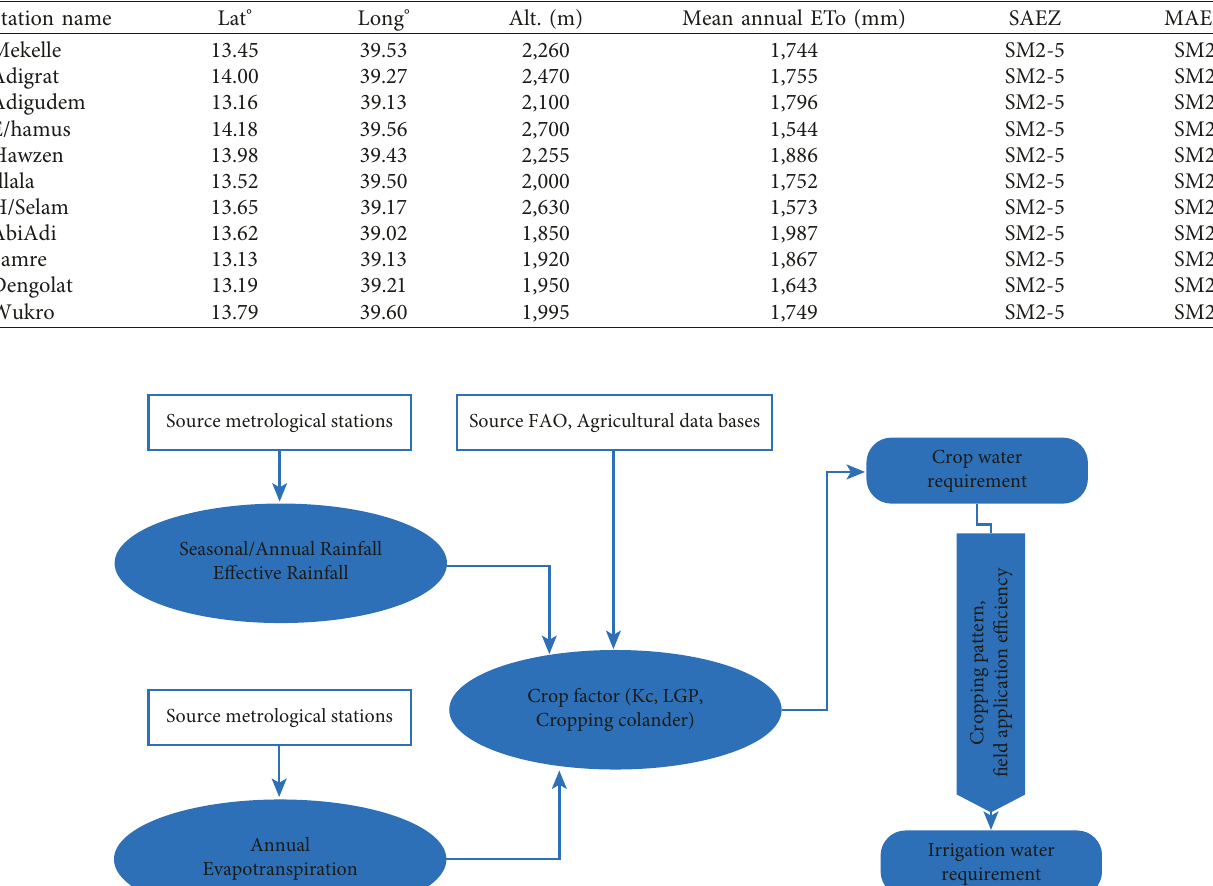
Table 2: Computed evapotranspiration of different agroecologies of the subbasin.